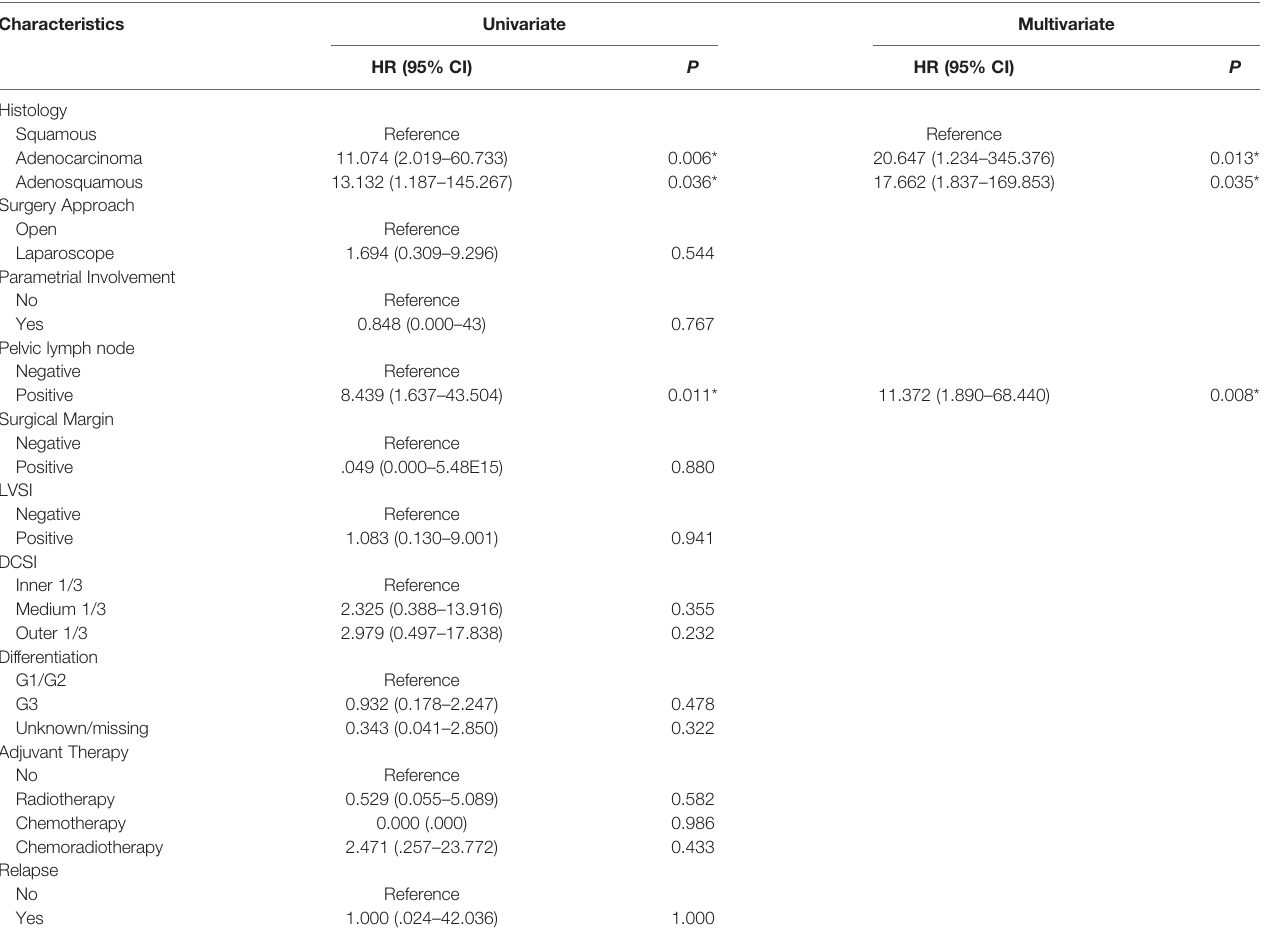
TABLE 3 | Factors Associated with Overall